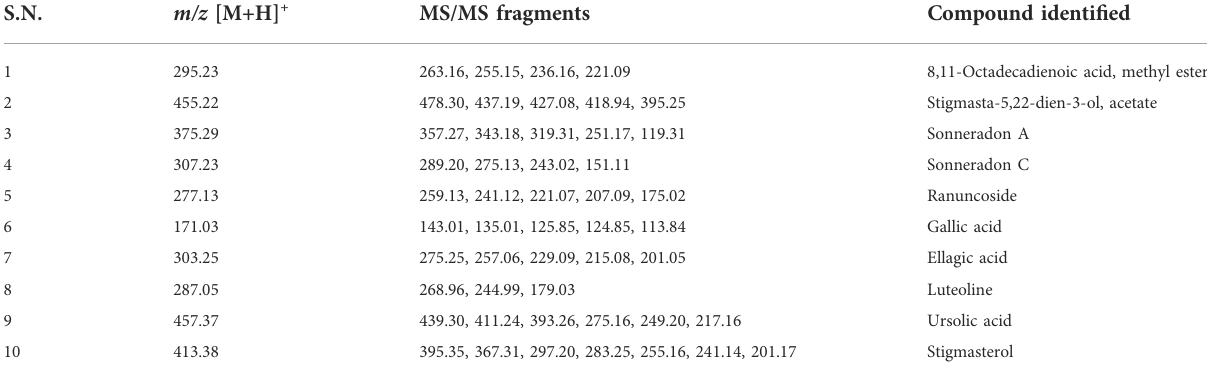
TABLE 4 Compounds identi fi ed from S. apetala fruit extract by LC-MS/MS spectroscopy. S.N. m/z [M+H] + MS/MS